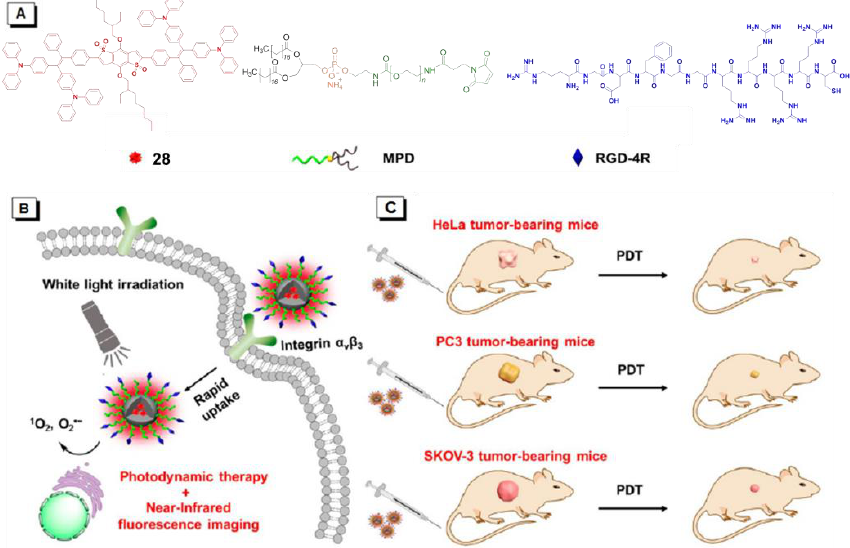
Figure 10. ( A ) Chemical structures of AIE – PS 28 , 1,2-distearoyl- sn -glycero-3-phosphoethanolamine - N -[maleimide(polyethylene glycol)-2000] (MPD), and RGD-4R. ( B ) Cellular uptake and PDT process of RGD-4R-MPD/ 28 NPs. ( C ) Xenograft tumor models of cervical, prostate, and ovarian cancers are established with HeLa, PC3, and SKOV-3 cells, respectively. Adapted and modified with permission from reference 71 (copyright 2020, American Chemical Society).